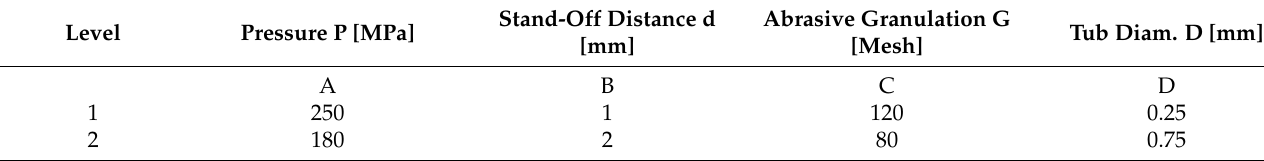
Table 6. Parameters proposed for Taguchi optimization.